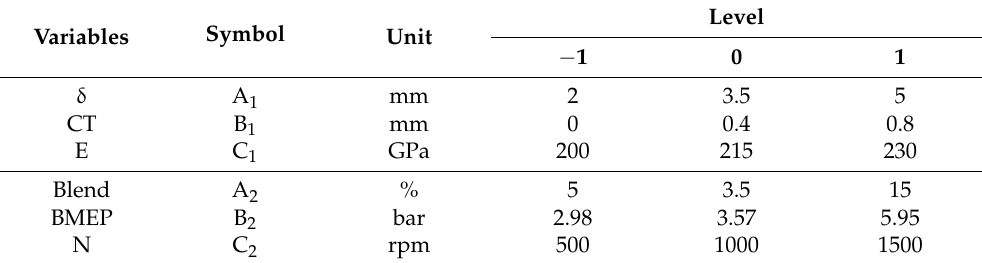
Table 4. Independent variables used for Box–Behnken design for optimization.